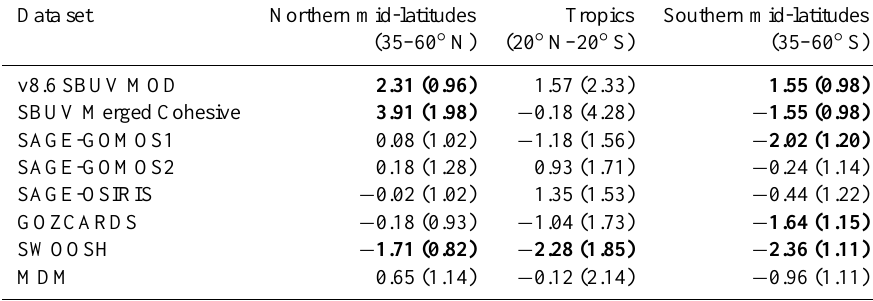
Table 12. As for Table 11 but for